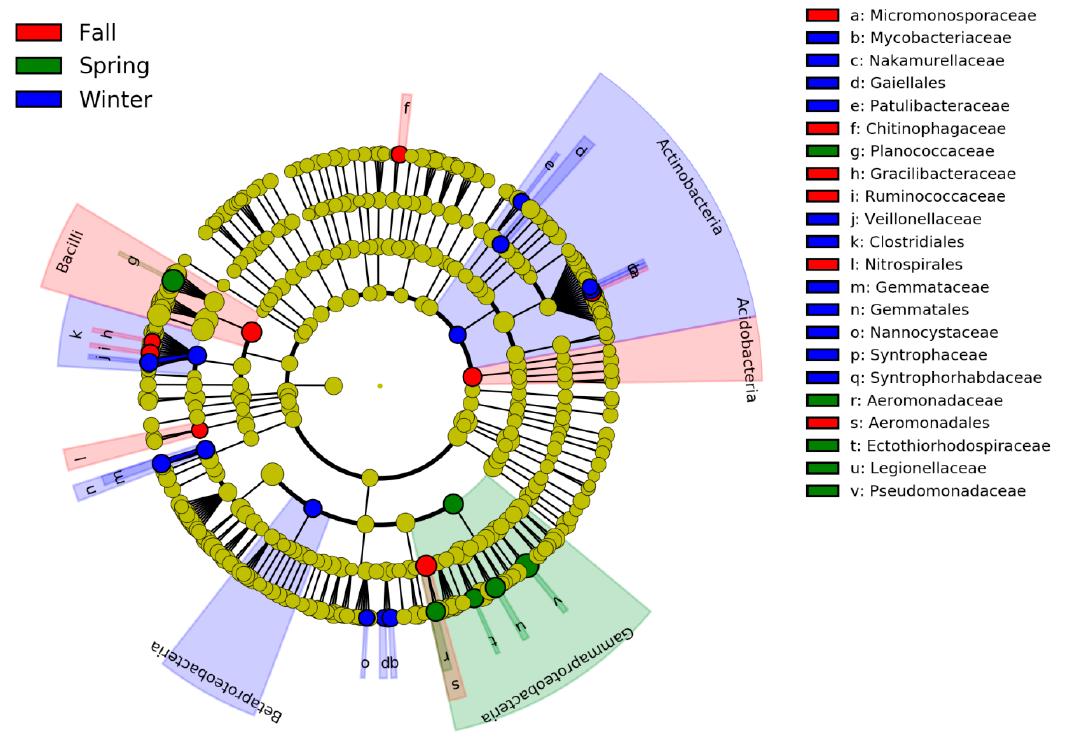
Figure 4. LEfSe analysis of the hooded crane gut bacterial biomarkers among three seasons. Cladogram represents the taxonomic hierarchical structure of the phylotype biomarkers identified among seasons. Identi fi ed phylotype biomarkers ranked by effect size (LDA > 2, P < 0.05). Red, phylotypes statistically overrepresented in fall; green, phylotypes statistically overrepresented in spring; blue, phylotypes statistically overrepresented in winter.